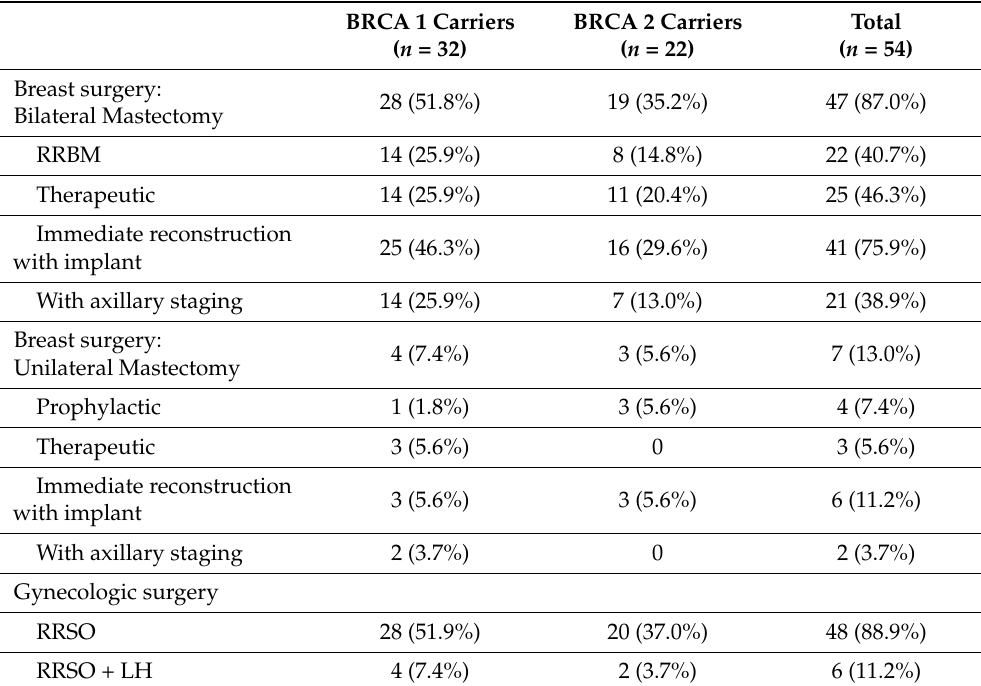
Table 2. Breast and gynecologic procedures